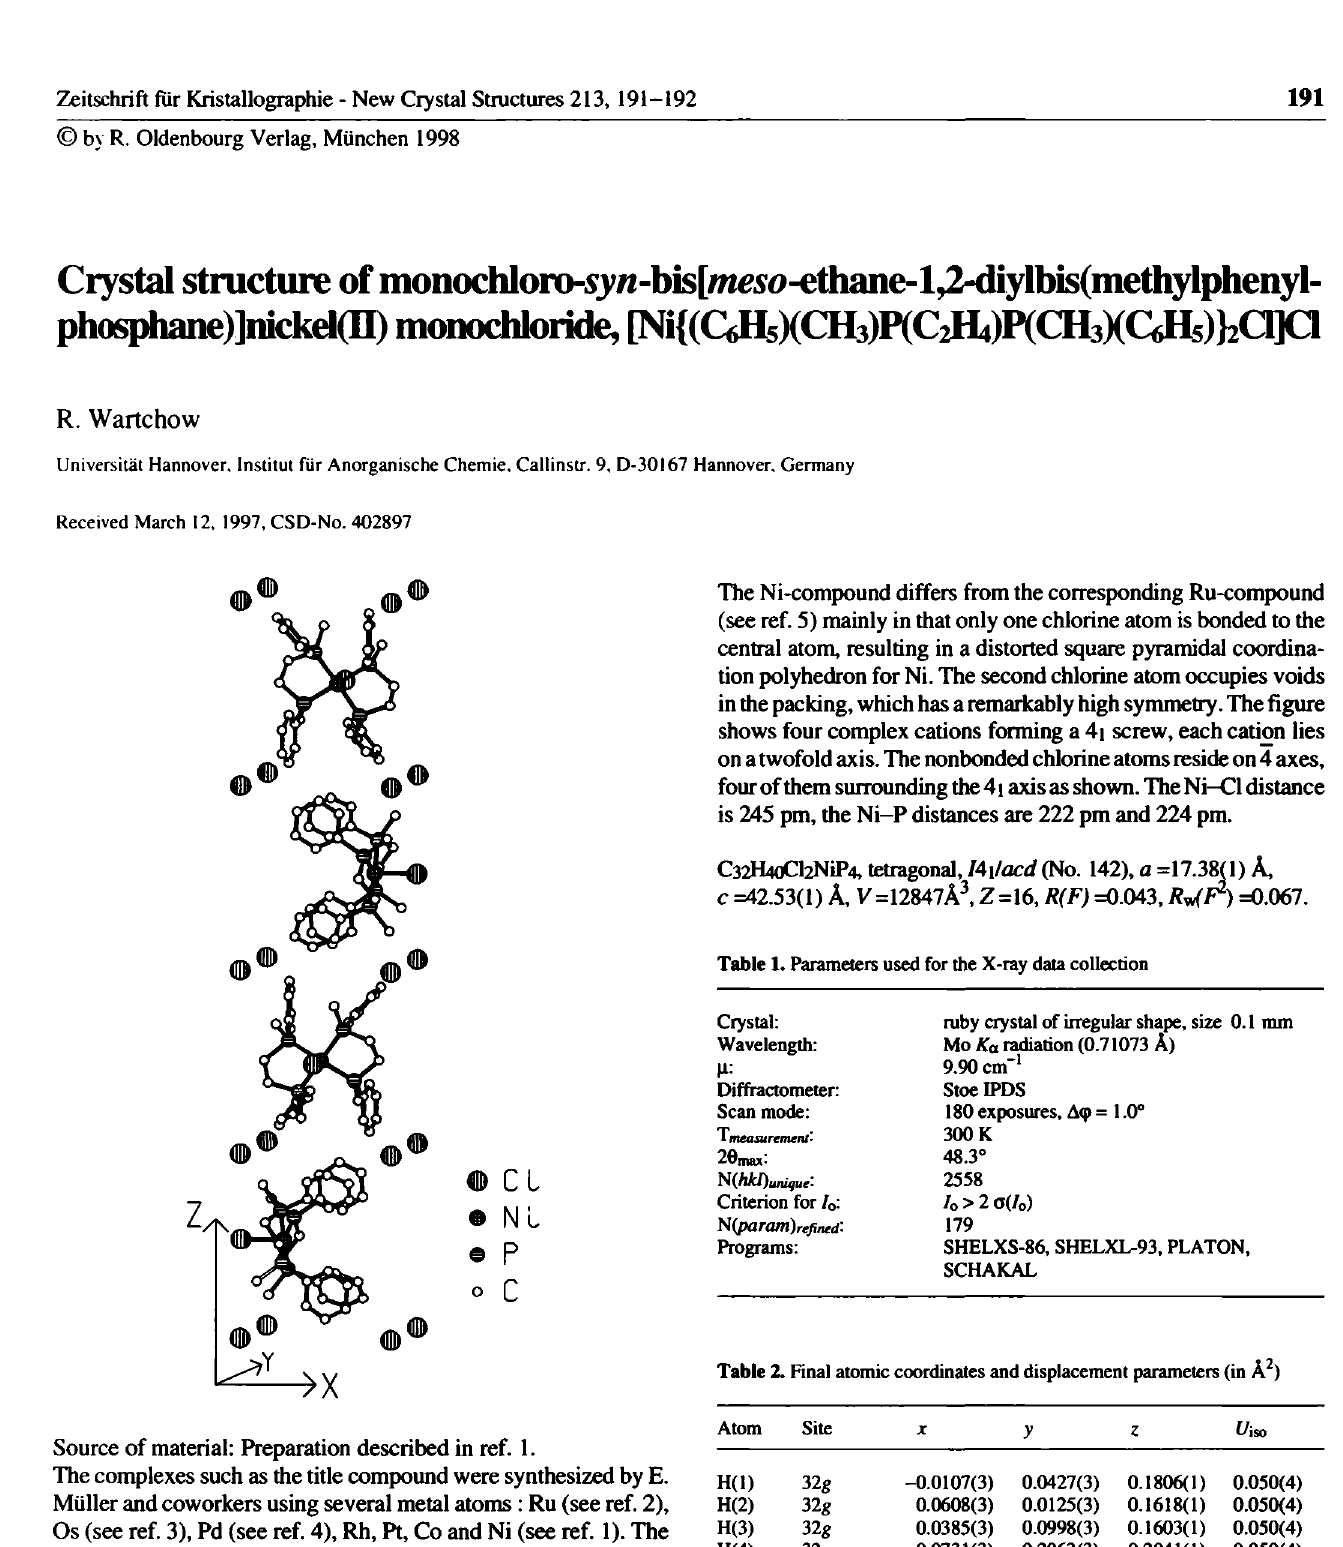
Table 2. Rnal atomic coordinates and displacement parameters (in